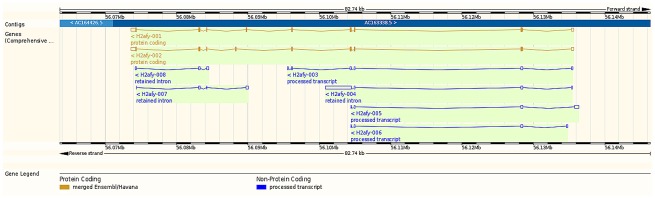
Relative location of the H2A histone family, member Y (H2afy) transcript isoforms associated with an alternative splicing event between microglia and macrophages (Ensembl, http://www.ensembl.org).Red denotes Ensembl protein coding, orange denotes merged Ensembl/Havana protein coding, and blue denotes processed transcript non-protein coding.